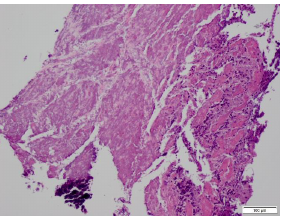
Figure 3. Necrotic tissue with prominent dystrophic